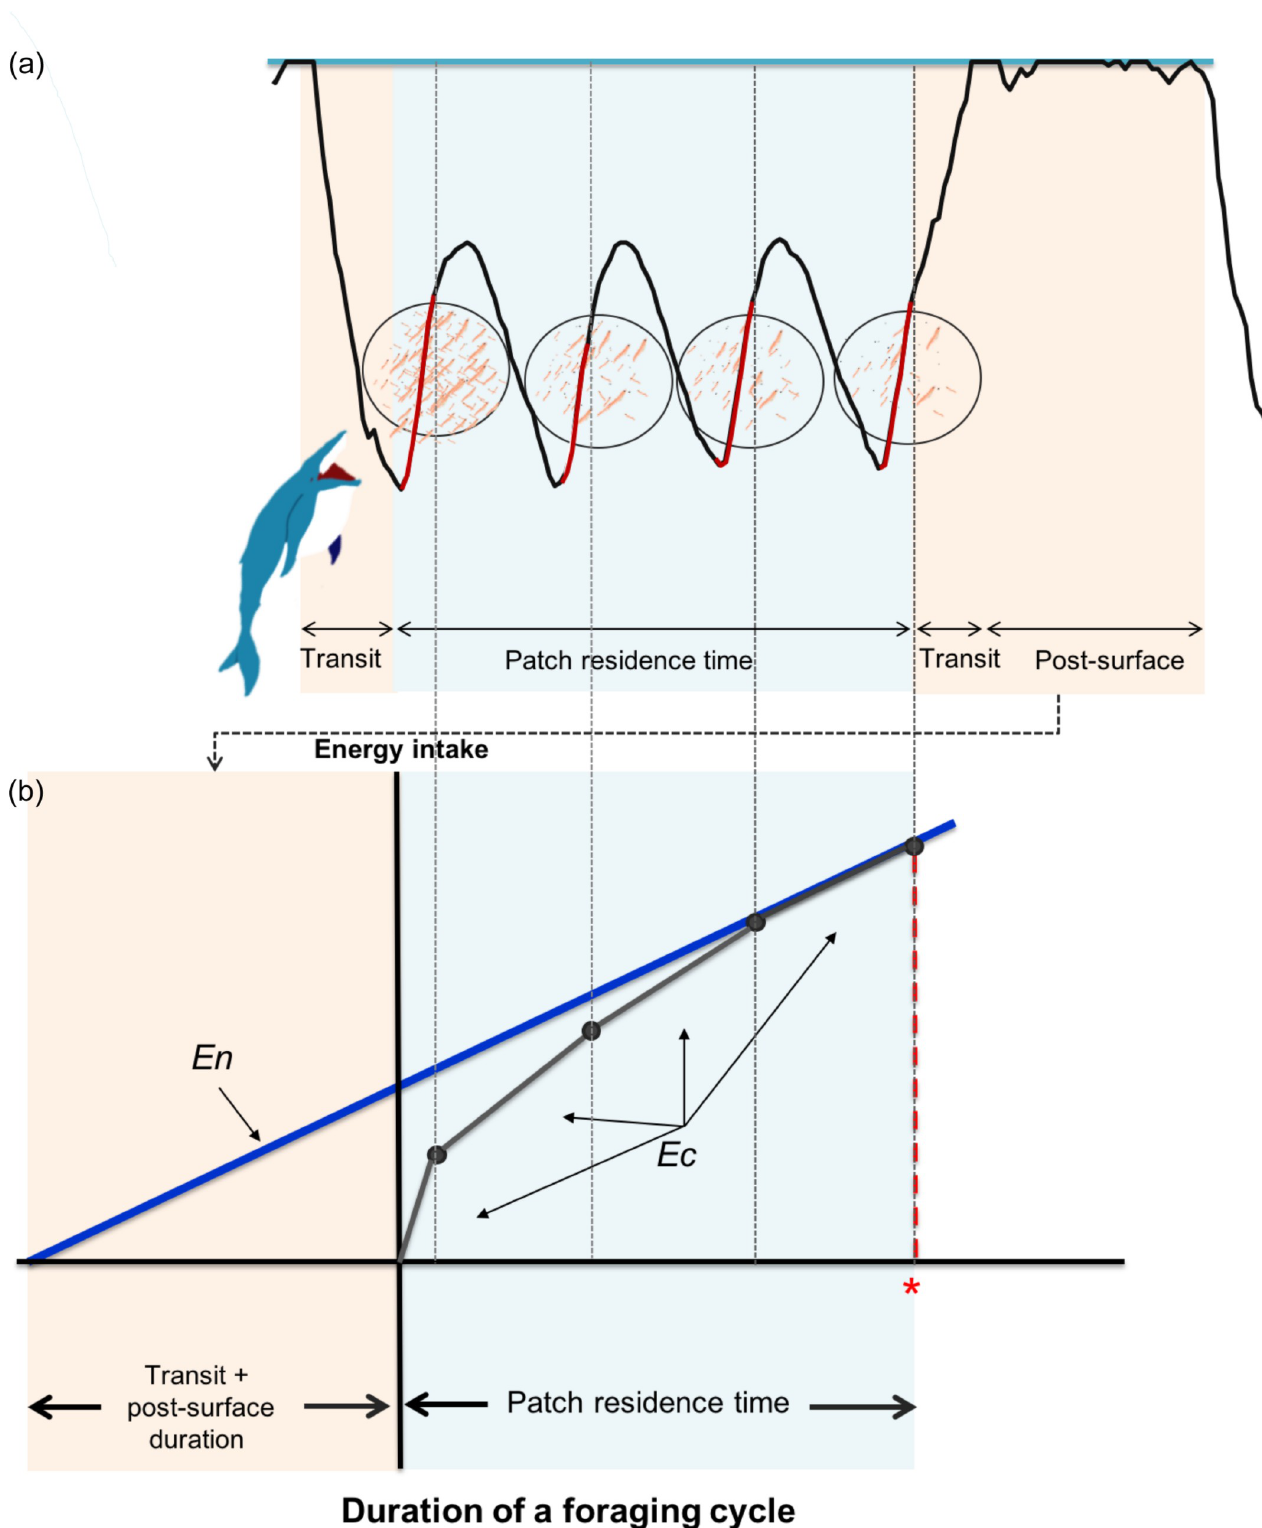
Fig 1. Illustration and diagram showing a gain function of a single dive with the optimal patch time according to the assumption of CPF. (a) A depth profile of a whale lunging (red lines) four times in a single dive. The energy intake of each lunge is the sum of the Index of Prey Density measured over the